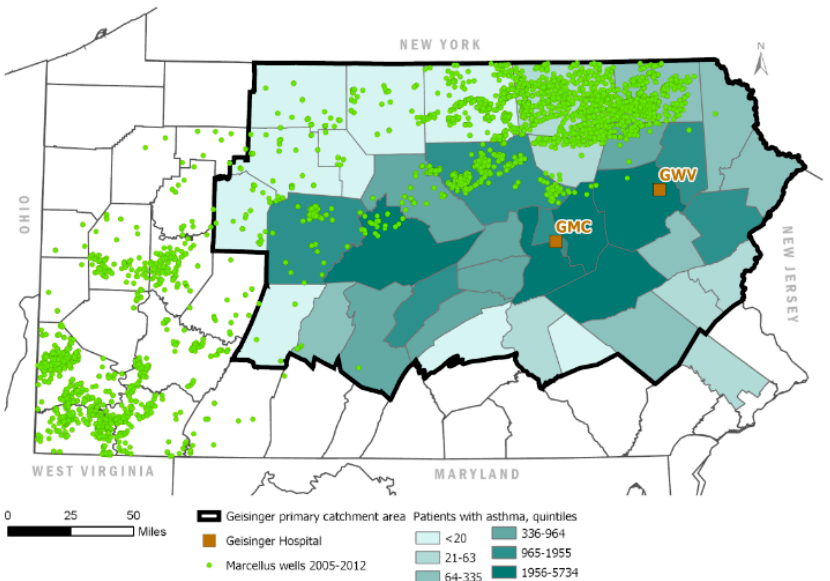
Figure 2. Adapted from Rasmussen et al. [3], showing the Geisinger primary catchment area relative to the location of unconventional wells spudded or in production during the period 2005–2012. Shading indicates the distribution of Geisinger asthma patients comprising the study population by county. GMC = Geisinger Medical Center, GWV = Geisinger Wyoming Valley. Figure was regenerated with data available through Shell’s licensing agreements with Esri and IHS Markit Ltd.